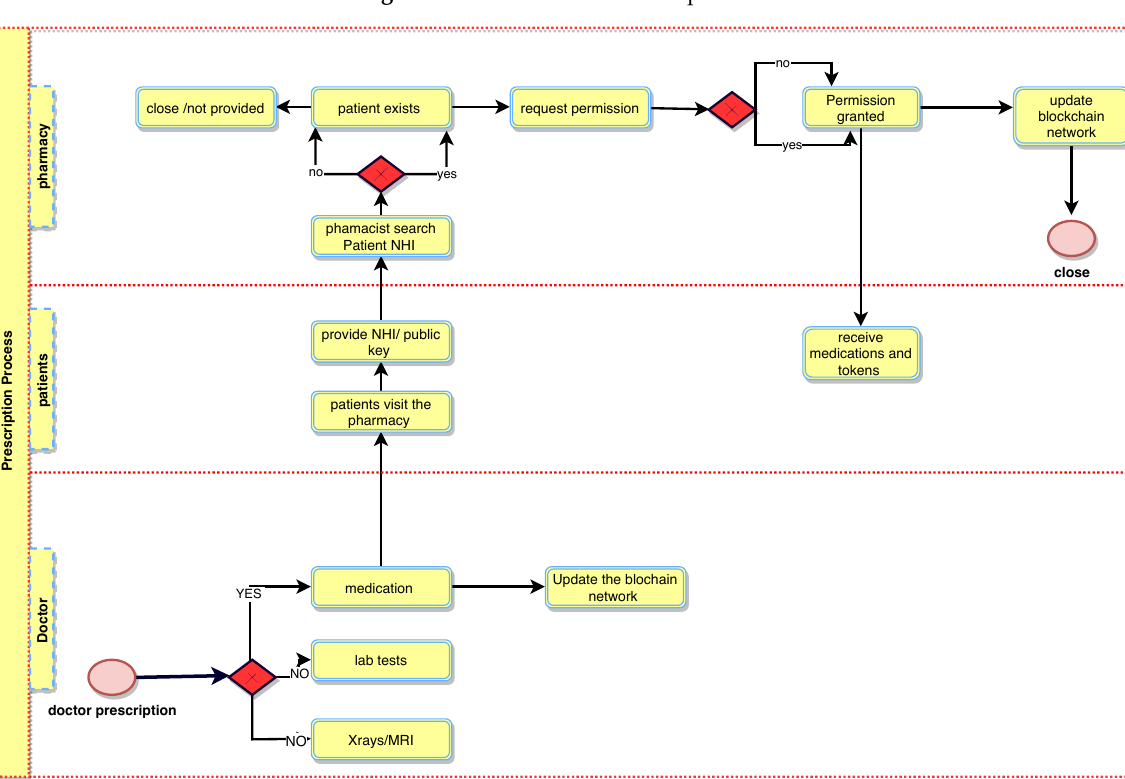
Figure 3. BlockPres consultation process.